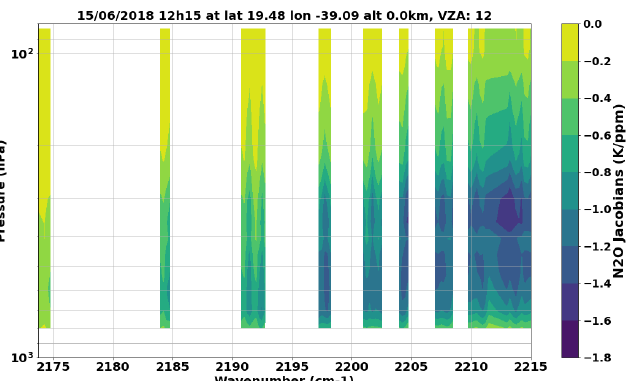
Figure 13. Example of N 2 O Jacobians at the NOPIR retrieval wave numbers, for 15 June 2018 at 19.5° N, 39.1° W.